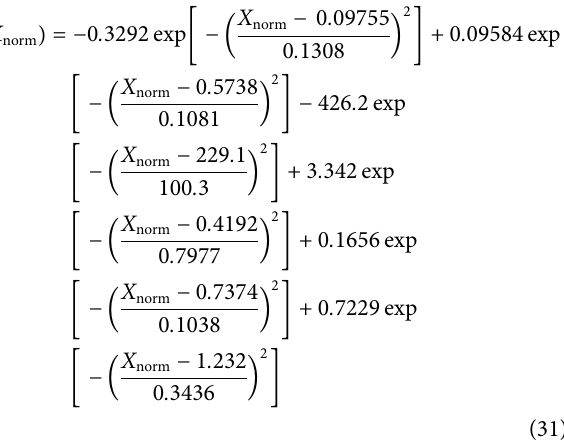
Frontiers in Materials |